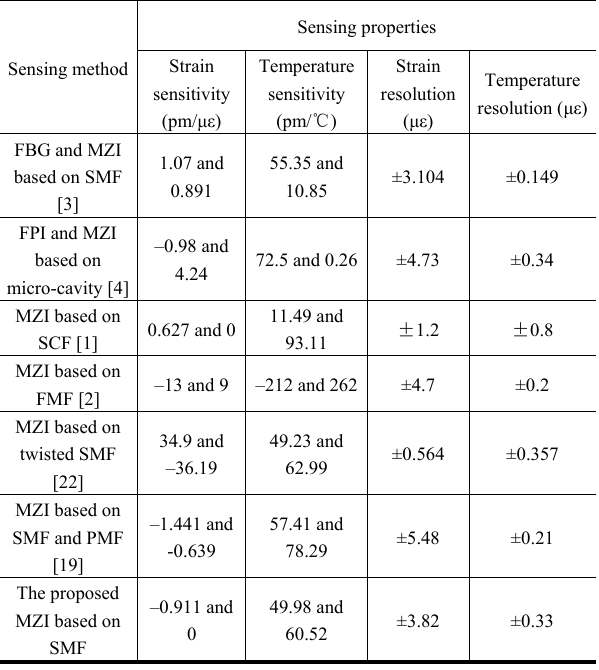
Table 1 Sensing properties of several MZI sensors for strain and temperature